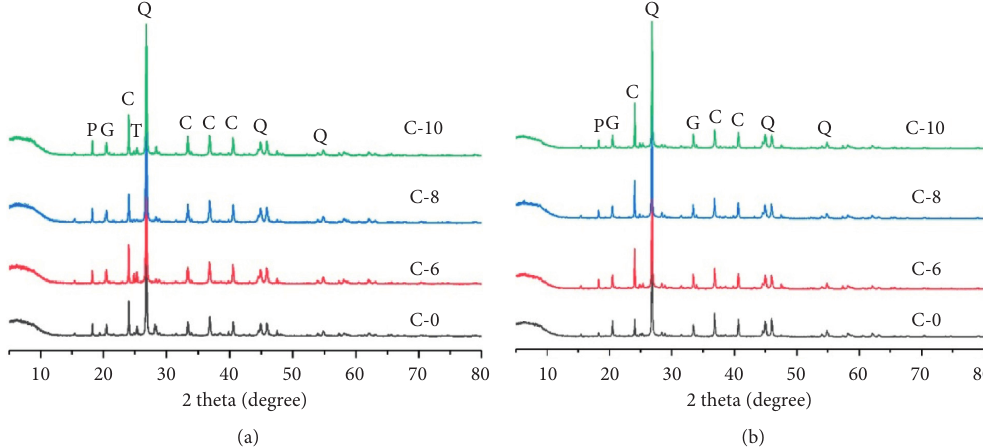
Figure 9: XRD patterns of sample freeze thawing 0times and 400times at 2 θ ranges from 5 ° to 80 ° . (a) freeze thawing 0 times, (b) freeze thawing 400 times (In XRD pattern, P is portlandite, C is calcite, G is gypsum, Q is quartz, and T is thaumasite).